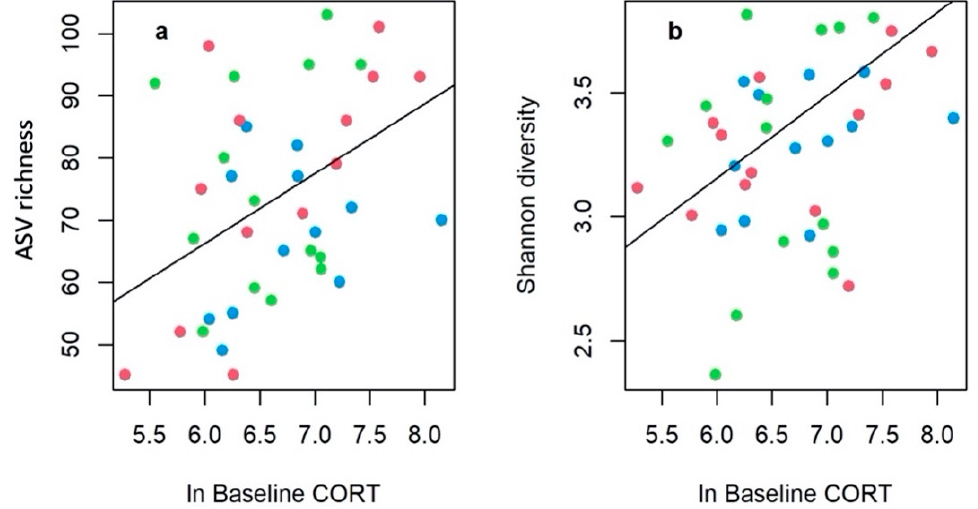
Figure 4. The significantly positive relationships between natural log transformed baseline corticosterone release rates (pg/g/h) and ( a ) bacterial (ASV) richness and ( b ) Shannon diversity of the tadpole gut bacterial communities. Regression lines were fitted from GEE models (Table S3) controlling for habitat type (natural: green, agricultural: red, urban: blue).